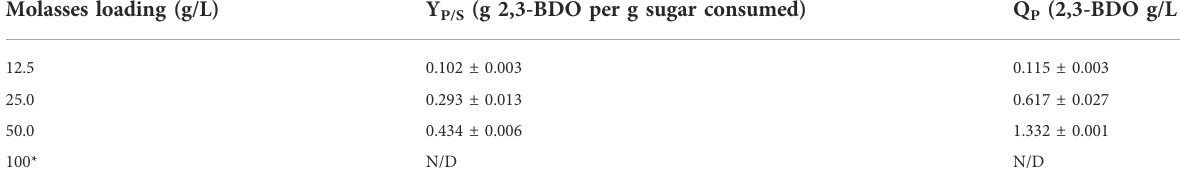
TABLE 2 2,3-Butanediol product yield and volumetric productivity at 24 h of aerobic fermentation of molasses media.